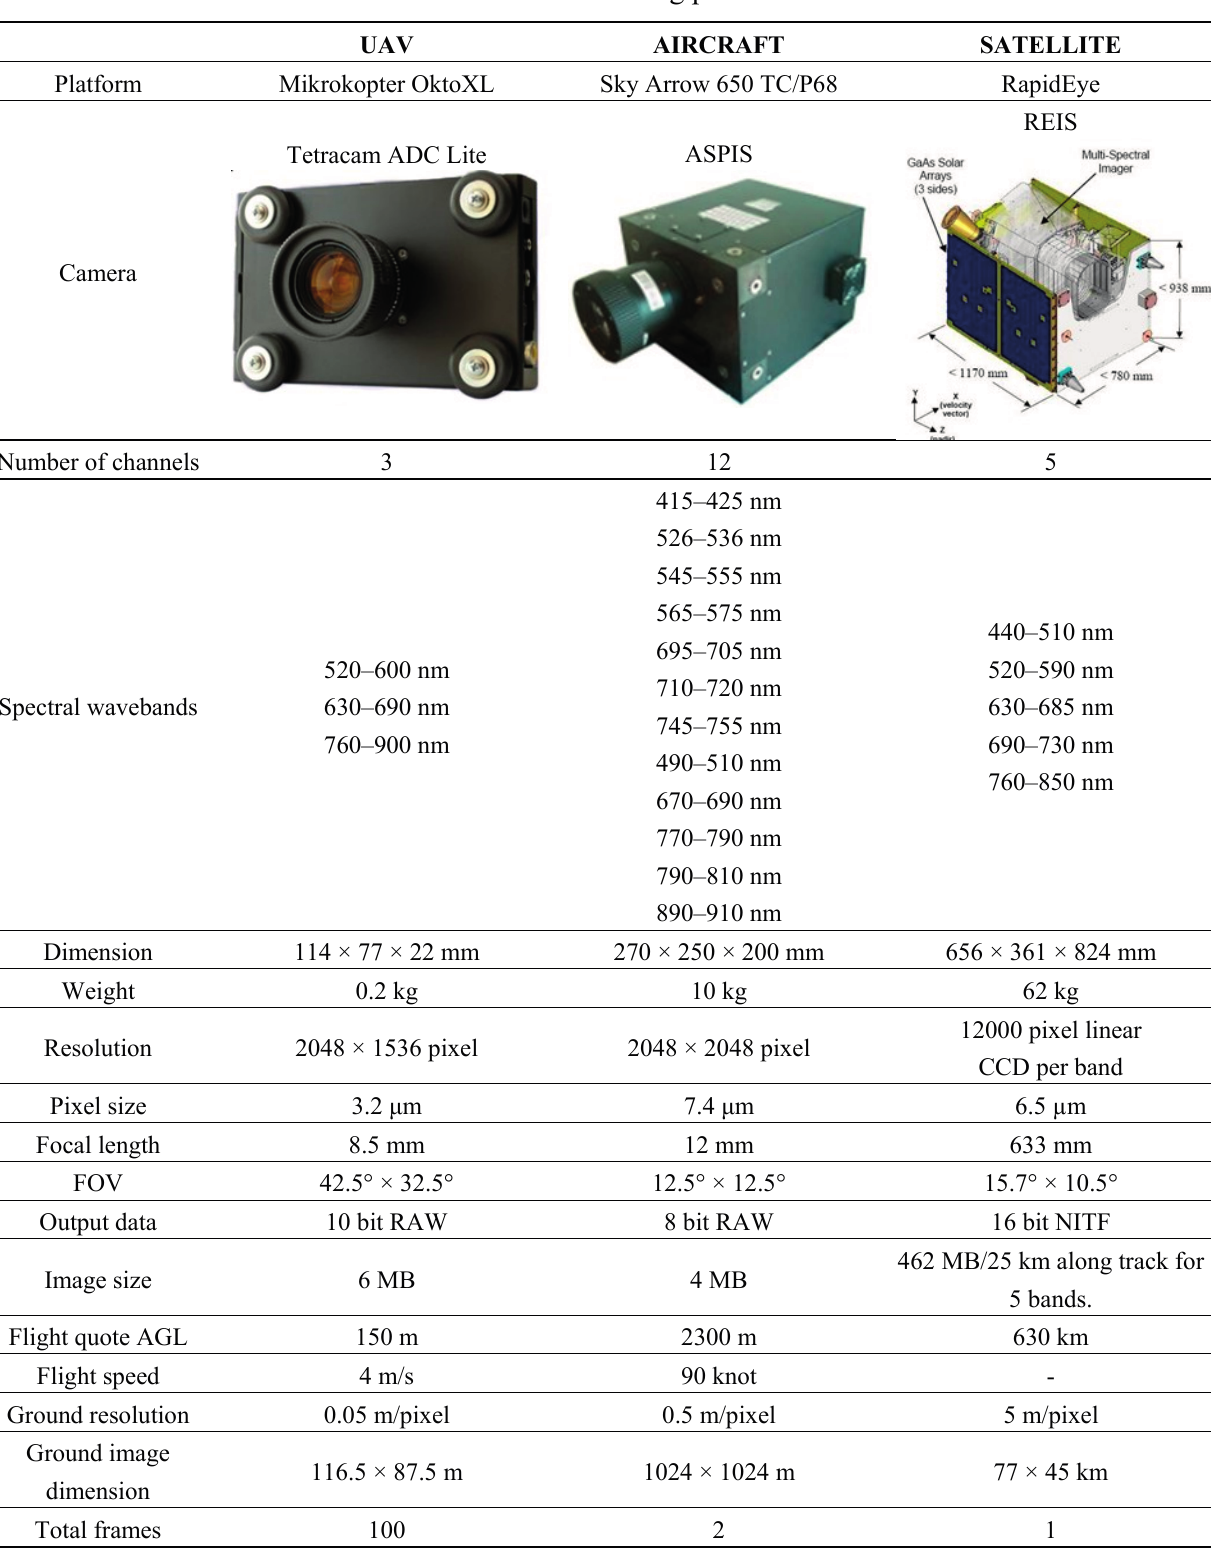
Table 1. Remote sensing